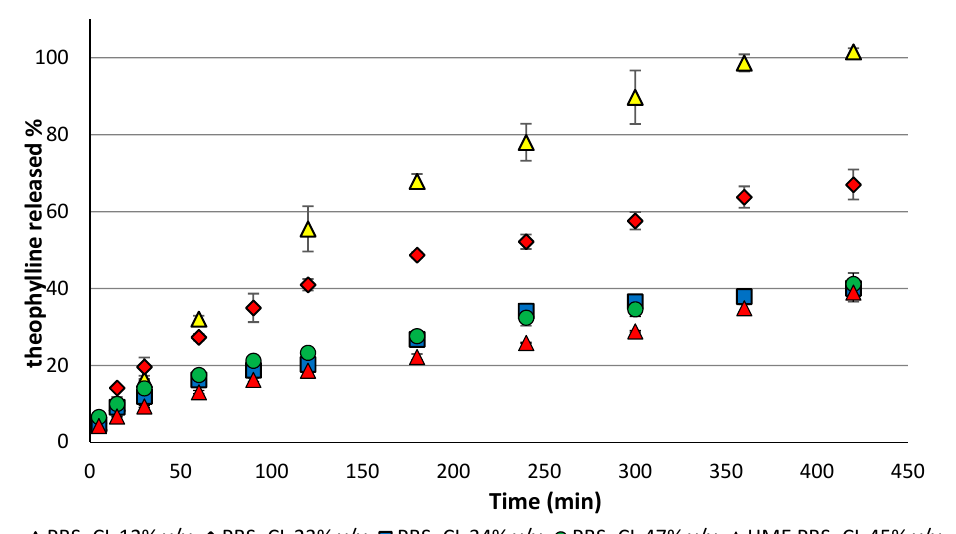
Figure 6. Dissolution profiles for PBS_CL tablets obtained by ultrasound-assisted compression and HME filaments.